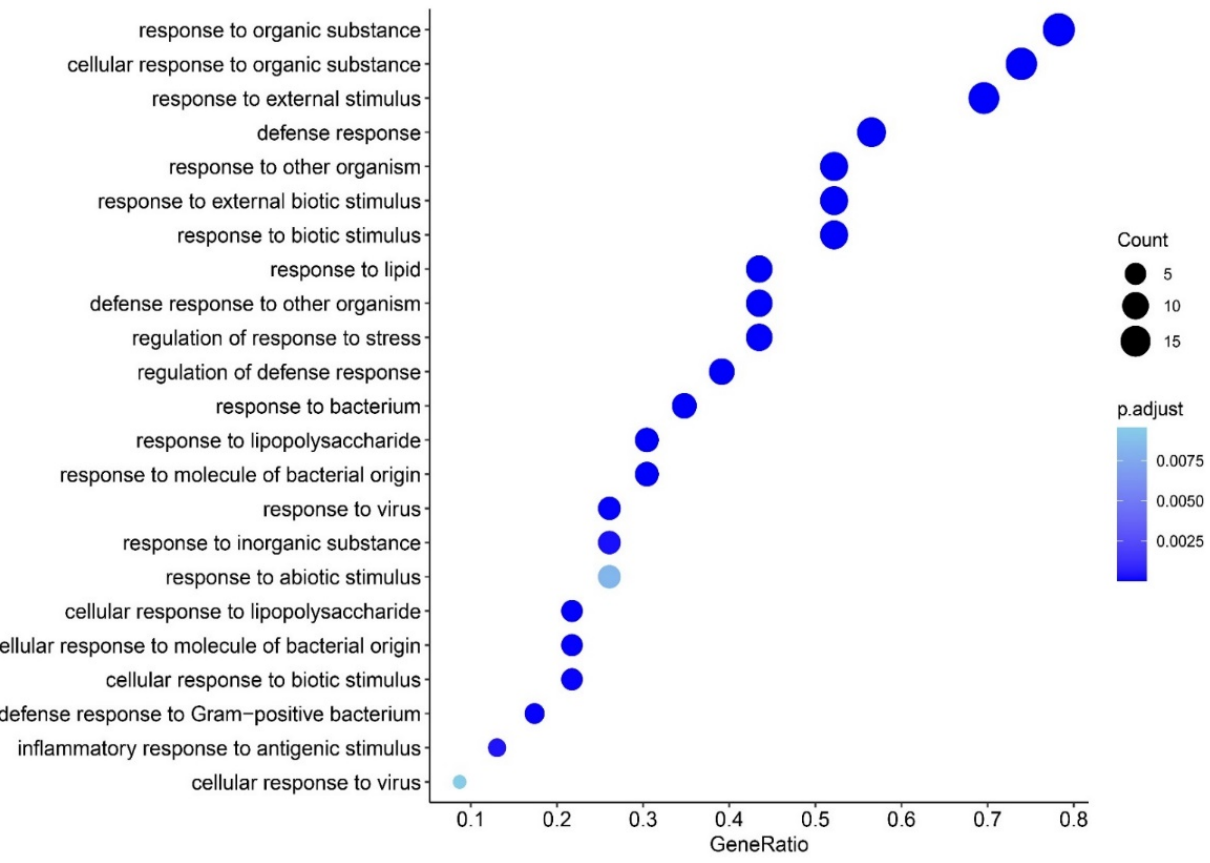
Figure 8. Results of annotation analysis using a custom-made GO list exploring the responses, cellular, or defense responses to a variety of mainly biotic stressors. Table 3. Results of inBio Discover annotation analysis with the DOID disease annotations classification in first episode psychosis and